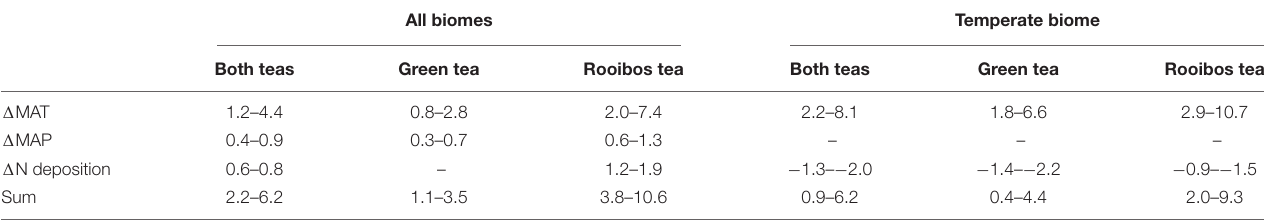
TABLE 5 | The percent change of mass loss of Green tea and Rooibos tea by the end of the 21st century relative to the current period, induced by the changes of mean annual temperature (MAT), mean annual precipitation (MAP), and N deposition across all biomes and in the temperate biome after 1 year of decomposition. All